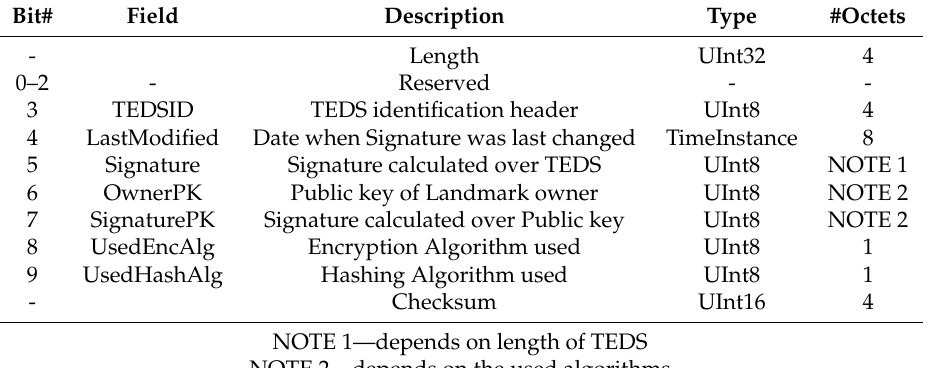
Table 1. IEEE 1451.0 security TEDS